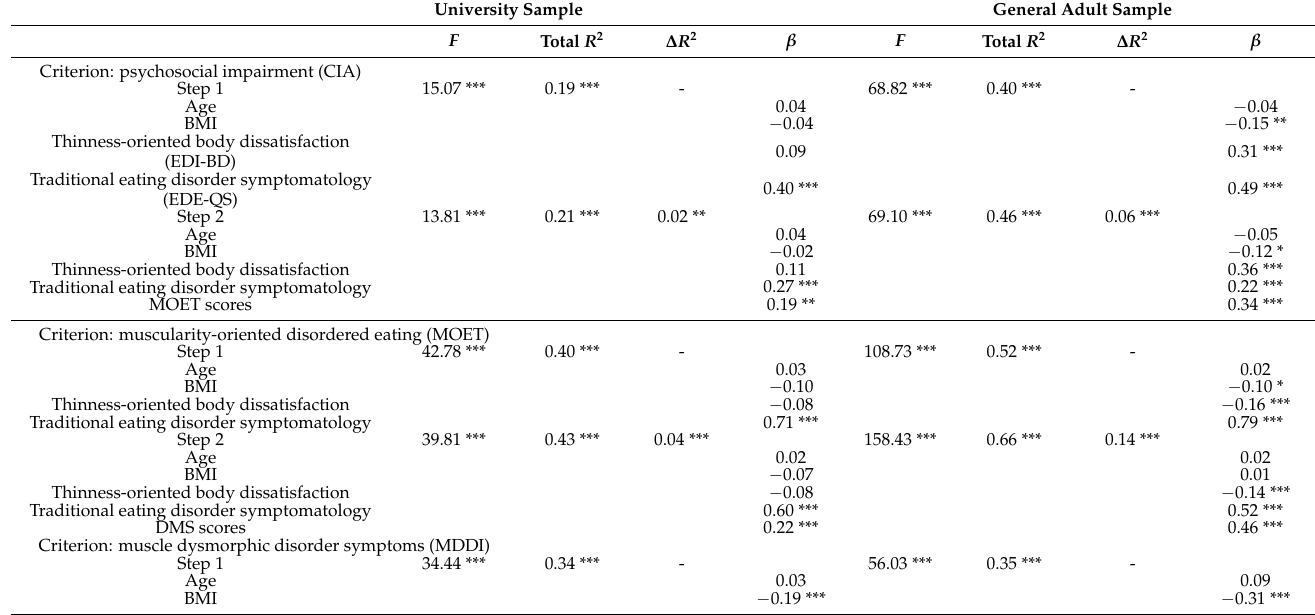
Table 6. Incremental contributions of the Muscularity-Oriented Eating Test (MOET), the drive for muscularity scale (DMS) and the Muscle Dysmorphic Disorder Inventory (MDDI) scores to the relevant criterion